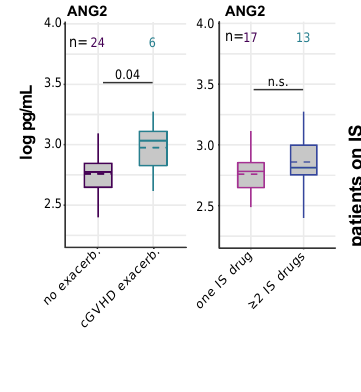
Whitney U test; ( b ) Logistic regression identifies independent factors associated with humoral responses post COVID-19 vaccination in the total cohort (index > 100, top), and in the subgroup of patients off IS (n = 107, index > 20, middle, index > 100, bottom). v1: first vaccination, v2: second vaccination, continuous variables were log10-transformed, OR odds ratio.